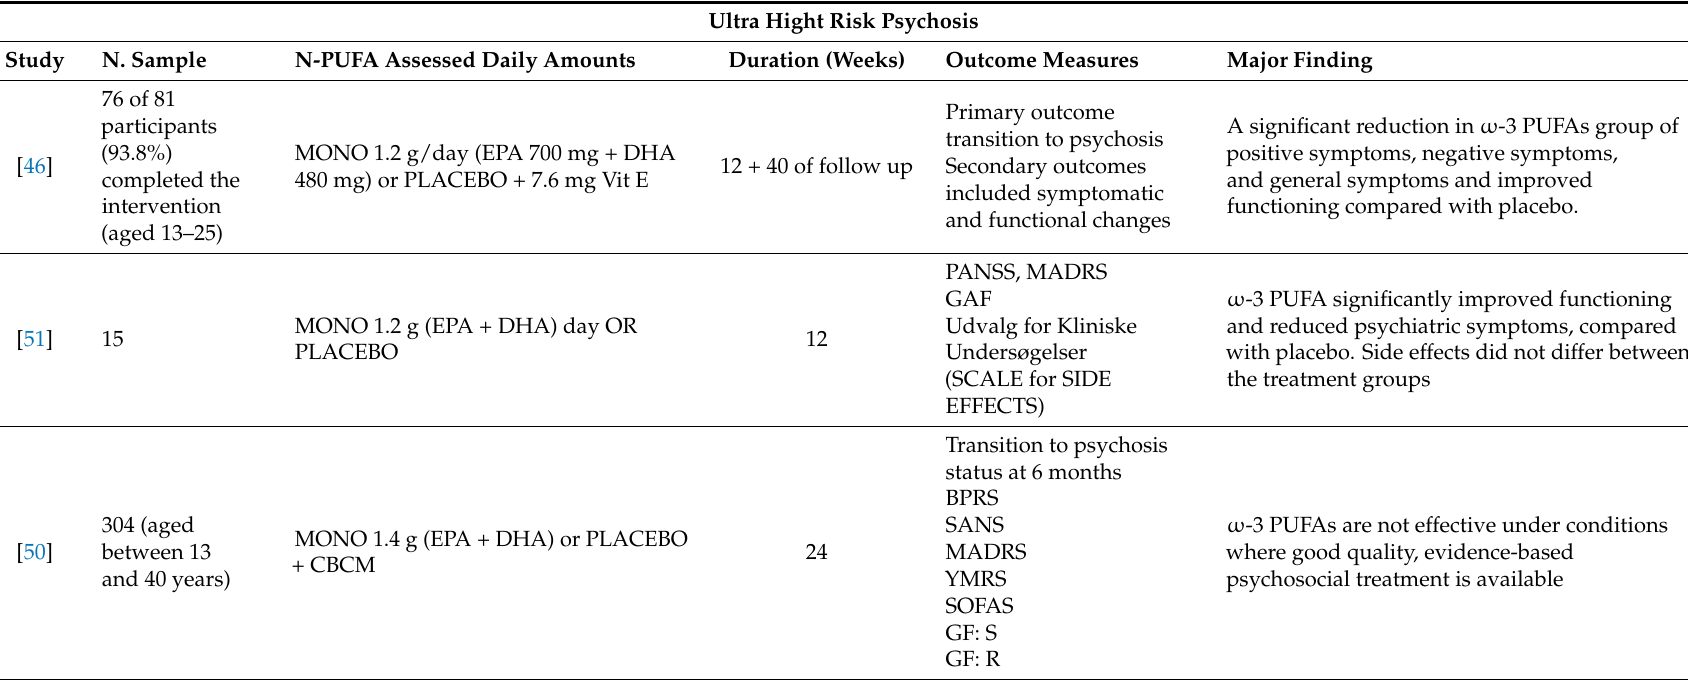
Table 1. RCTs of ω -3 PUFAs supplementation in early psychotic symptoms (ultra-high risk of psychosis and first psychotic episode), ADHD and ASD. Ultra Hight Risk